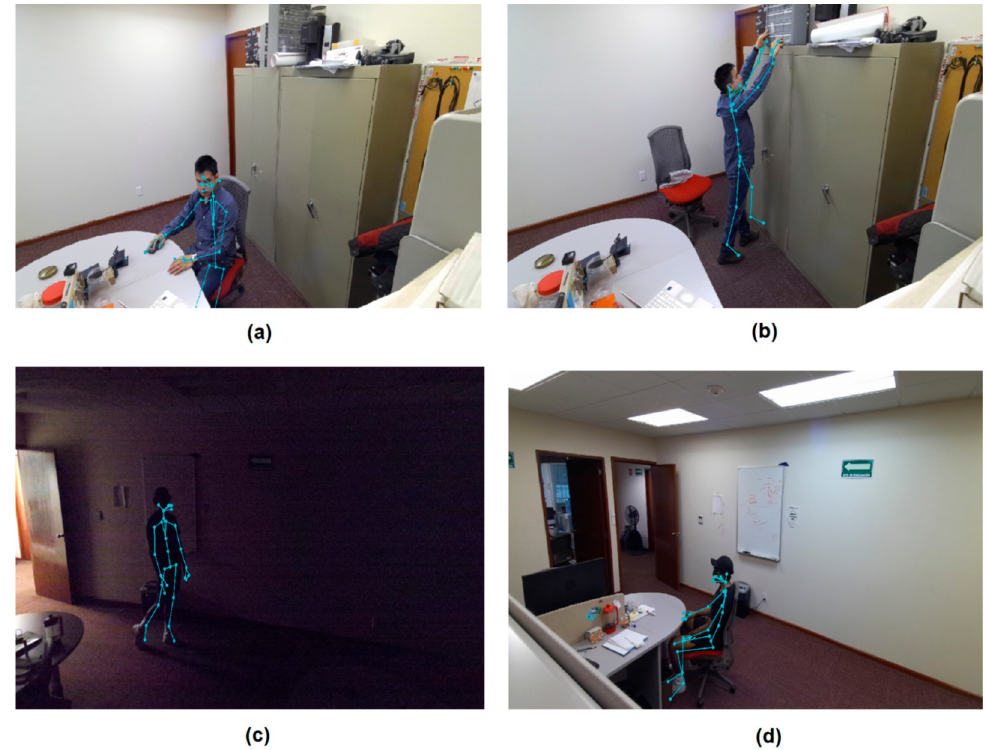
Figure 16. ( a ) Partial occlusion for sitting on subject 1; ( b ) raising hands in different positions from